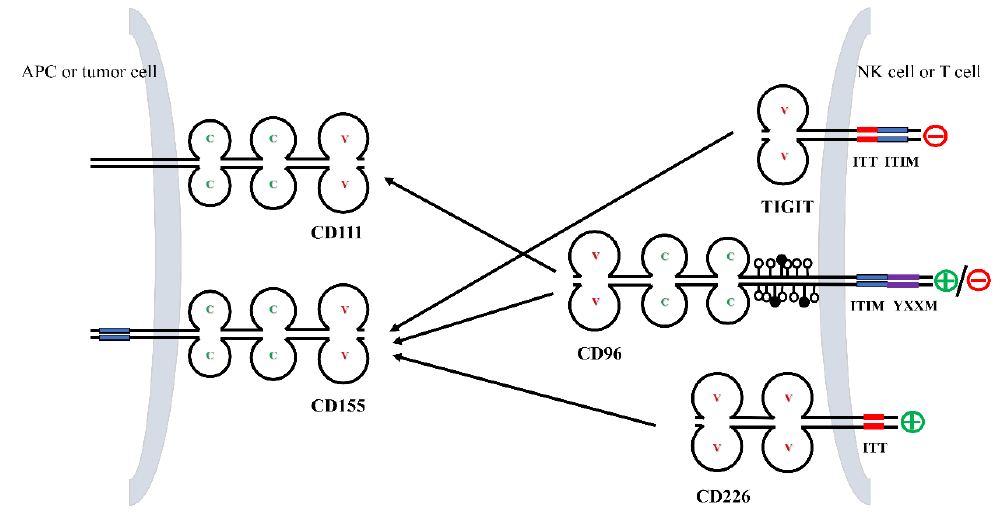
Figure 2. Interactions between members of the CD96 axis. TIGIT, CD96, and CD226 on NK cells and T cells bind to their ligands CD155 and CD111 with different affinities. Residues in the cytoplasmic tail of TIGIT, CD96, and CD226 are phosphorylated and generate co-stimulatory or co-inhibitory signals.